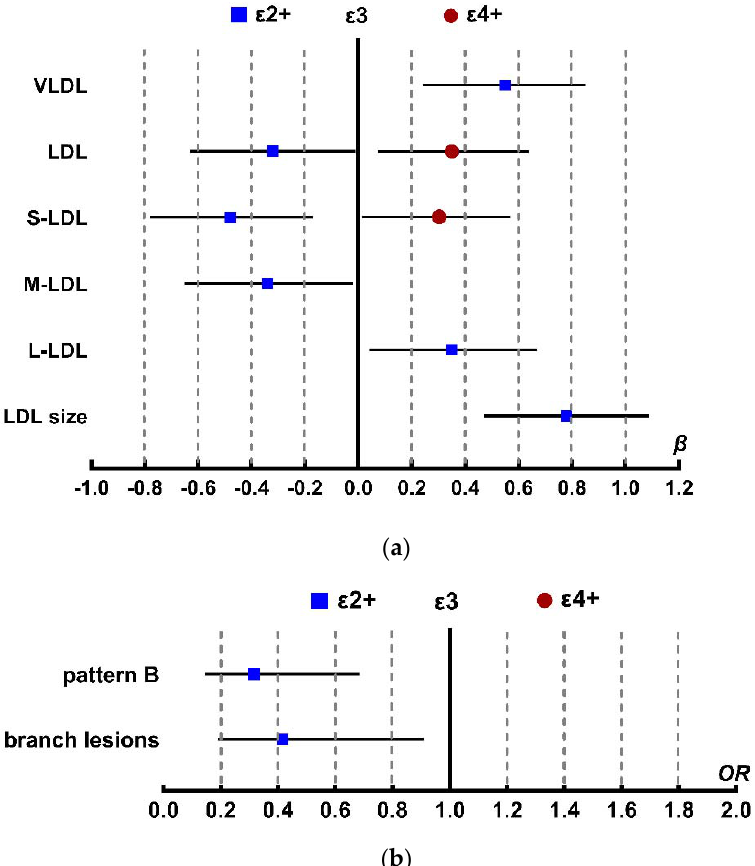
Figure 2. APOE affects the lipoprotein particle profile and the severity of CHD. Multiple linear regression and logistic regression models were adjusted for gender, age, diabetes, BMI, HbA1c, hs-CRP, ALT, and Cr. For clarity of illustration, only results of the analyses with p < 0.05 are shown here. ( a ) Multiple linear regression β -coefficients (x-axis)expressed by standard deviation (SD) units indicate the change in lipoprotein particle concentration over APOE genotype groups ( ε 2+, ε 3, and ε 4+). The most common ε 3 group is set at the origin as a reference group and compared with ε 2+ (squares) and ε 4+ (circles) groups. Abbreviations: VLDL, very low-density lipoprotein; LDL, low-density lipoprotein; S-LDL, small low-density lipoprotein; M-LDL, median low-density lipoprotein; L-LDL, large low-density lipoprotein; ( b ) Logistic regression models are used to measure APOE effects on LDL density pattern and the severity of CHD. Table 2. APOE genotypes and LDL density patterns in 360